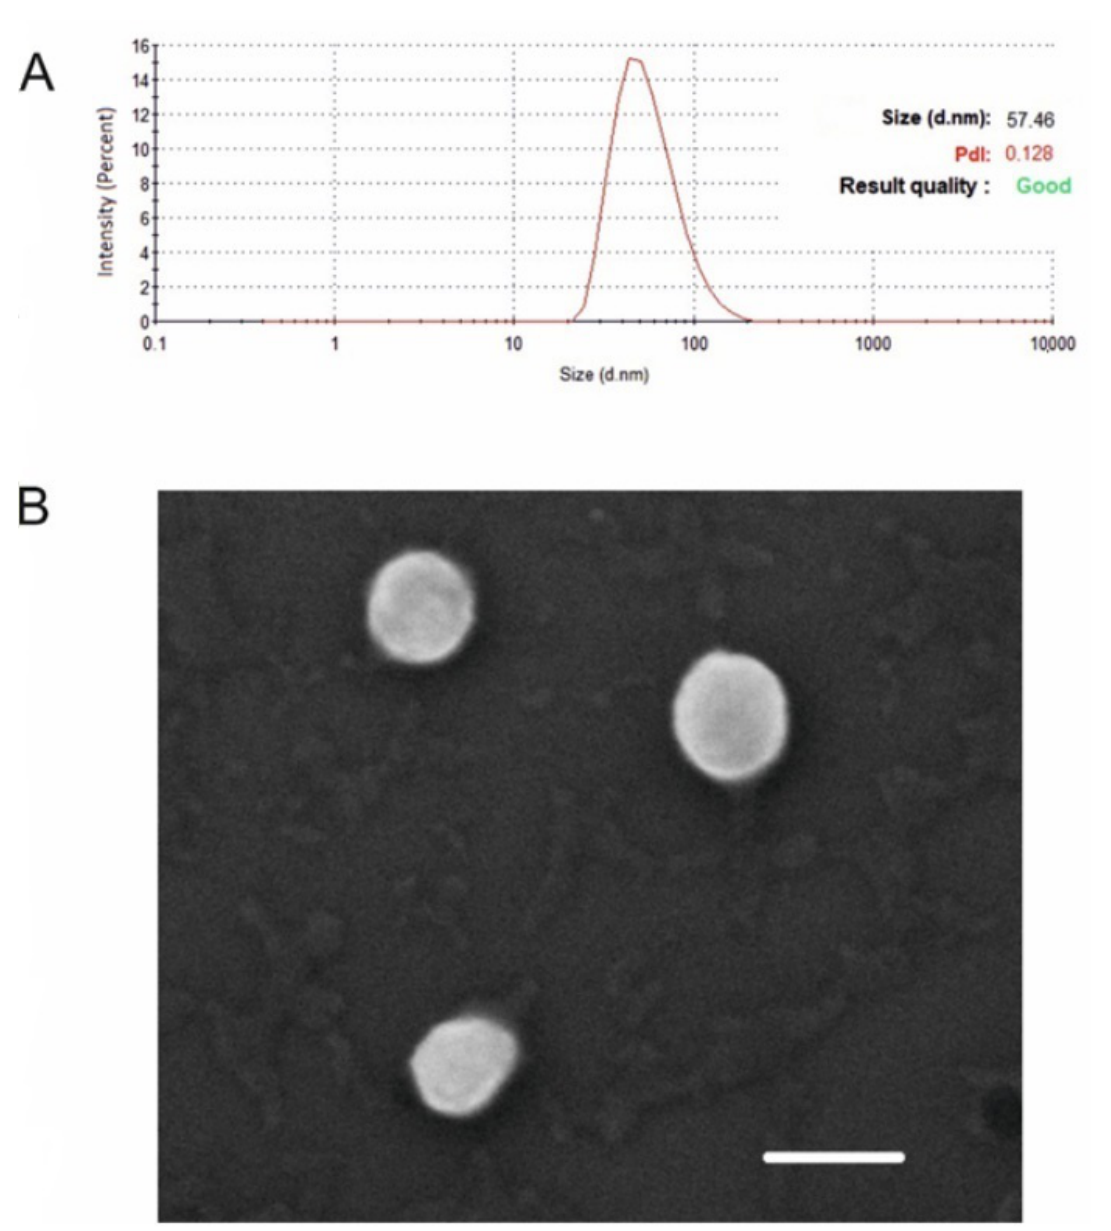
Figure 1. Size distribution by intensity and PDI of PLGA-PTB-NPs, as measured by DLS ( A ). SEM micrographs of PLGA-PTB-NPs (Scale bar: 100 nm) ( B ).